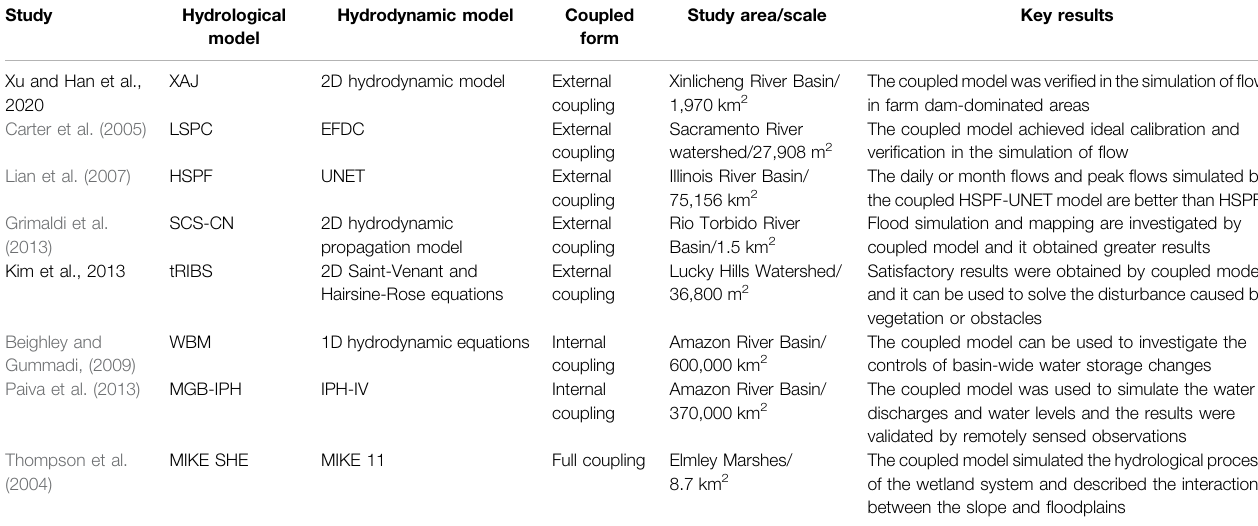
TABLE 6 | Research on the coupled hydro-hydrodynamic model.